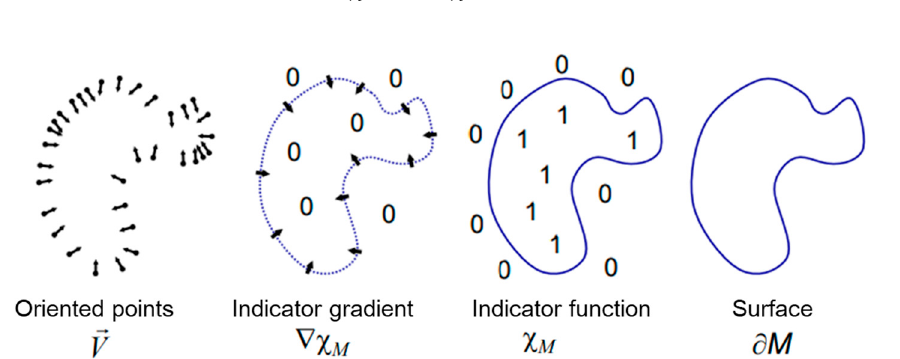
Figure 4. Concept of Poisson surface reconstruction in 2D.